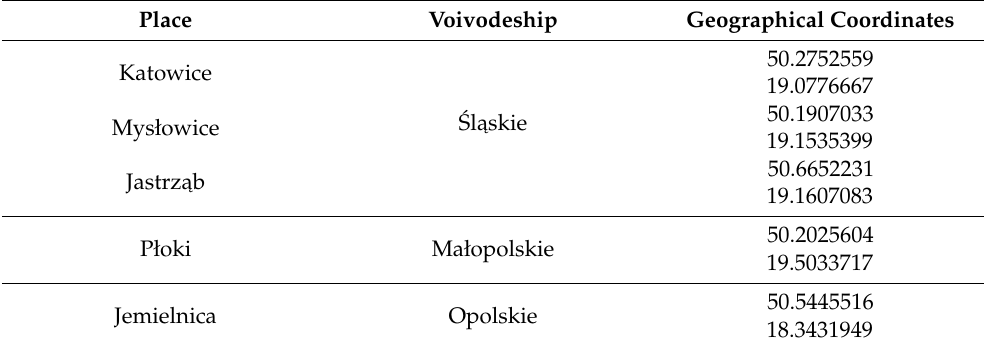
Table 1. Four tested plant species were collected from each location. Table 1. Location of spice growing points in southern